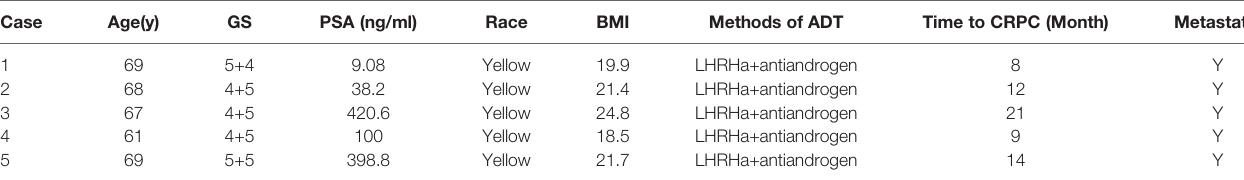
TABLE 1 | Clinical characteristics of